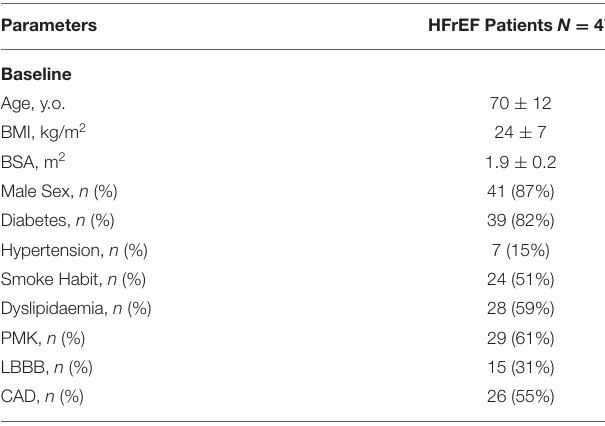
TABLE 1 | General characteristics of the whole population.